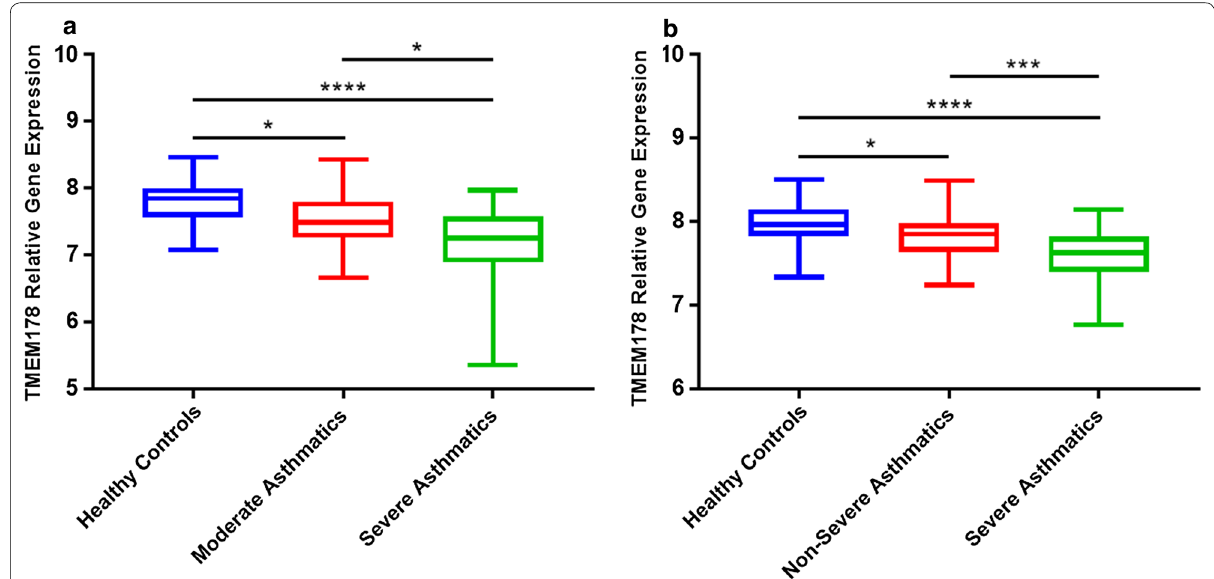
Fig. 1 Relative gene expression of TMEM178 is decreased in asthmatics when compared to healthy controls and this reduction progresses with asthma severity. a Data obtained from GSE43696. b Data obtained from GSE63142. ****p‑value < 0.0001; ***p‑value < 0.001; *p‑value <